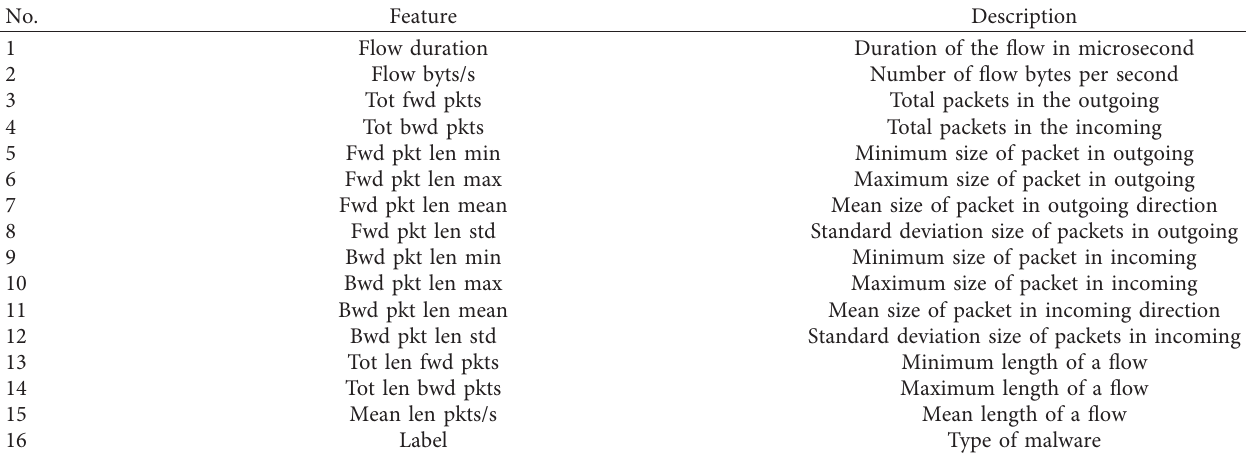
Table 2: Features of network traffic conversations [42].